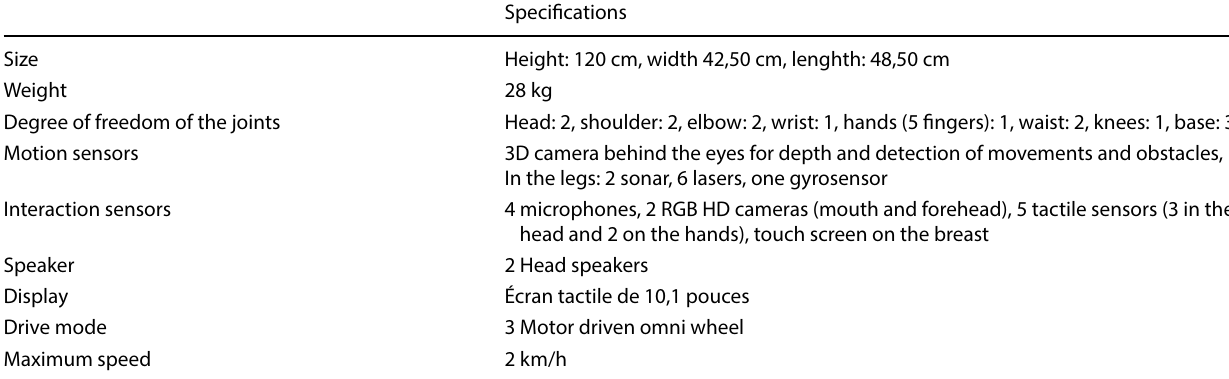
Table 1 Technical specifications of the robot